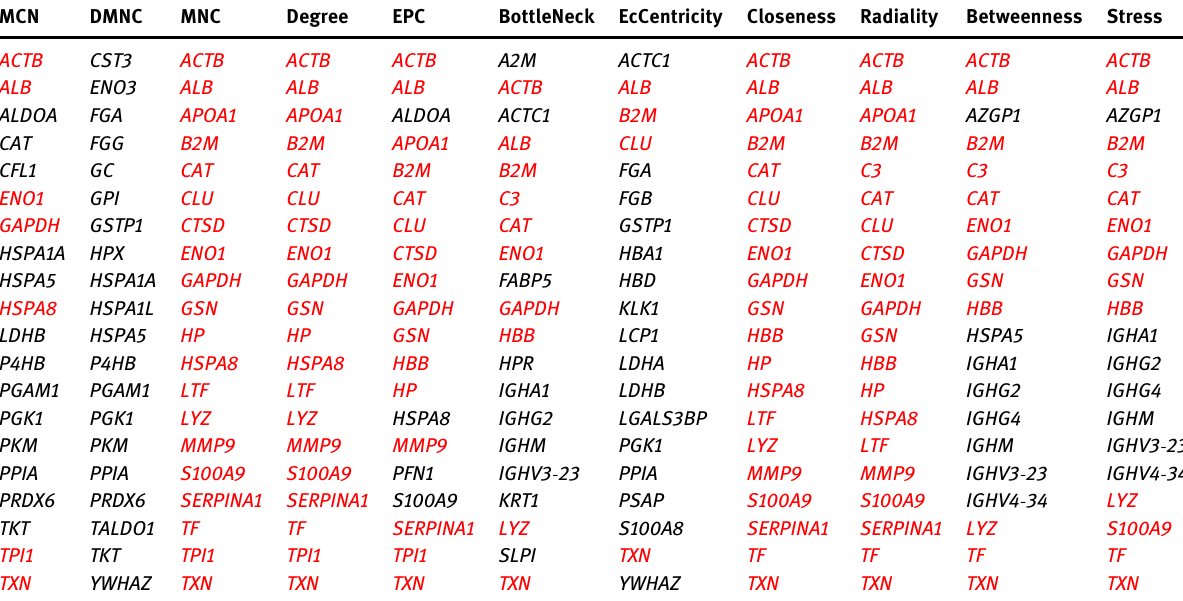
Table 5: 22 Major hub genes ( in red ) identi fi ed by di ff erent algorithms of the cytoHubba plug - in